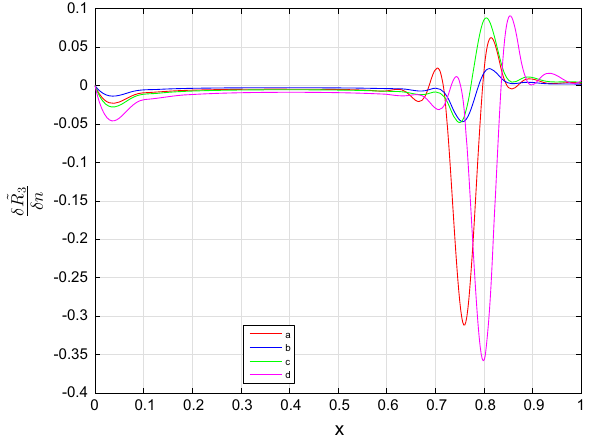
as a function of x for n